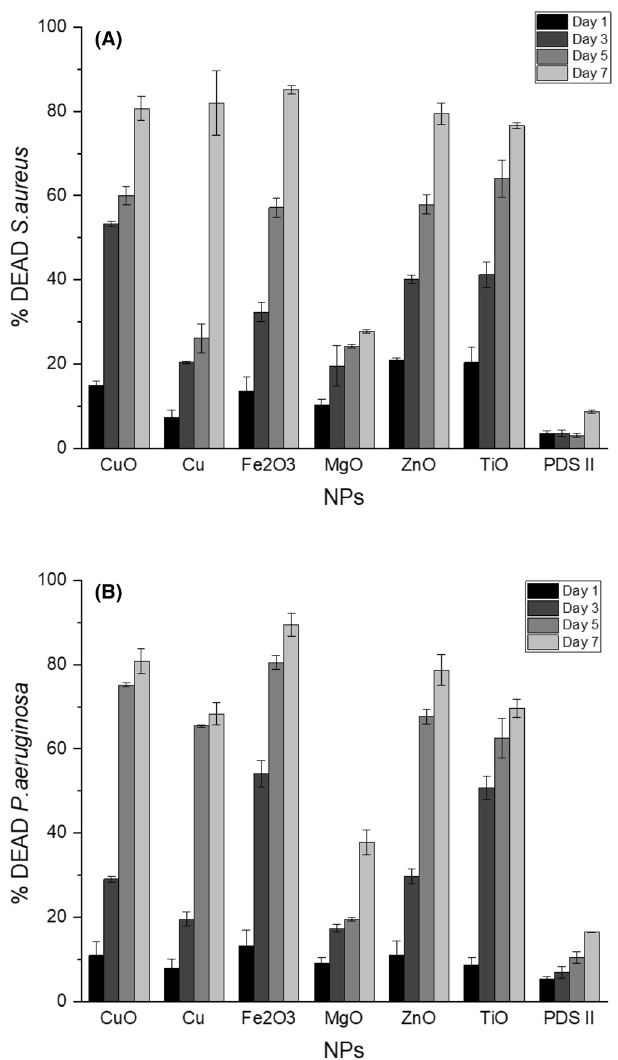
Figure 5. Mean percentage of dead Staphylococcus aureus ( A ) and Pseudomonas aeruginosa ( B ) under different metallic nanoparticle suture coating treatments (n = 12). Four timepoints were observed at 1, 3, 5 and 7 days after exposure to coated